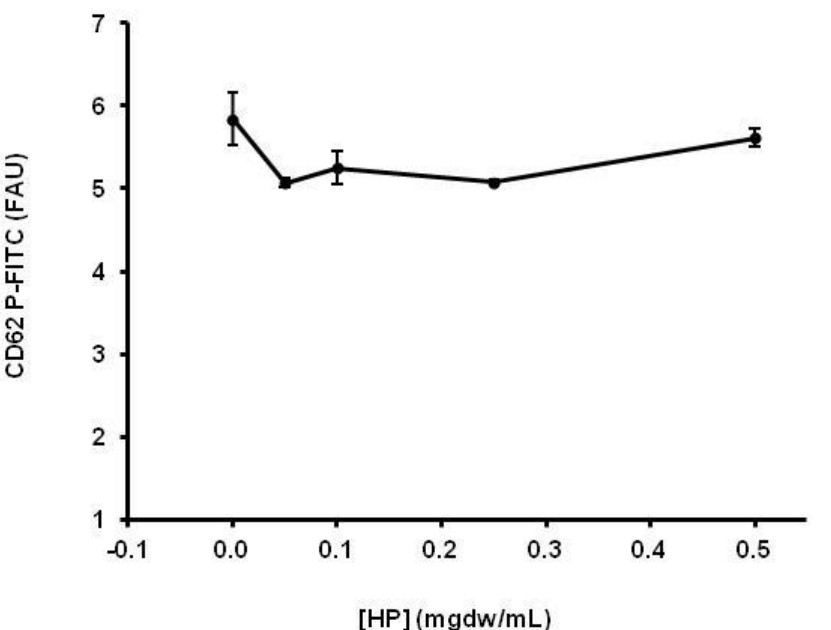
Figure 4. Effect of HP on thrombin-induced CD62P expression (0.05 U/mL), assessed by mean fluorescence intensity. Data are presented as mean +/ − SEM for three different experiments with the same donor. FAU: CD62P-FITC-fluorescence units in the total platelet population (CD41+ events). The values were not statistically different.